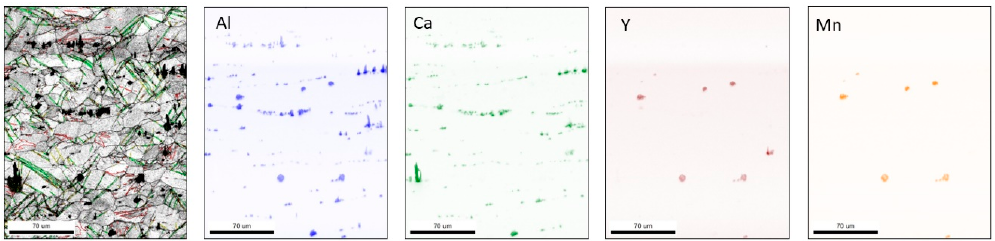
Figure 4. Grain boundary map and alloying elements distribution maps the as-rolled sheet by 450-dec rolling scheme, at the same measuring area with the Figure 3b. Different colors of the boundaries, in the grain boundary map, correspond to the twin types: red to {10 − 12} extension, yellow to {10 − 11} contraction and green to {10 − 12} − {10 − 11} secondary twins.